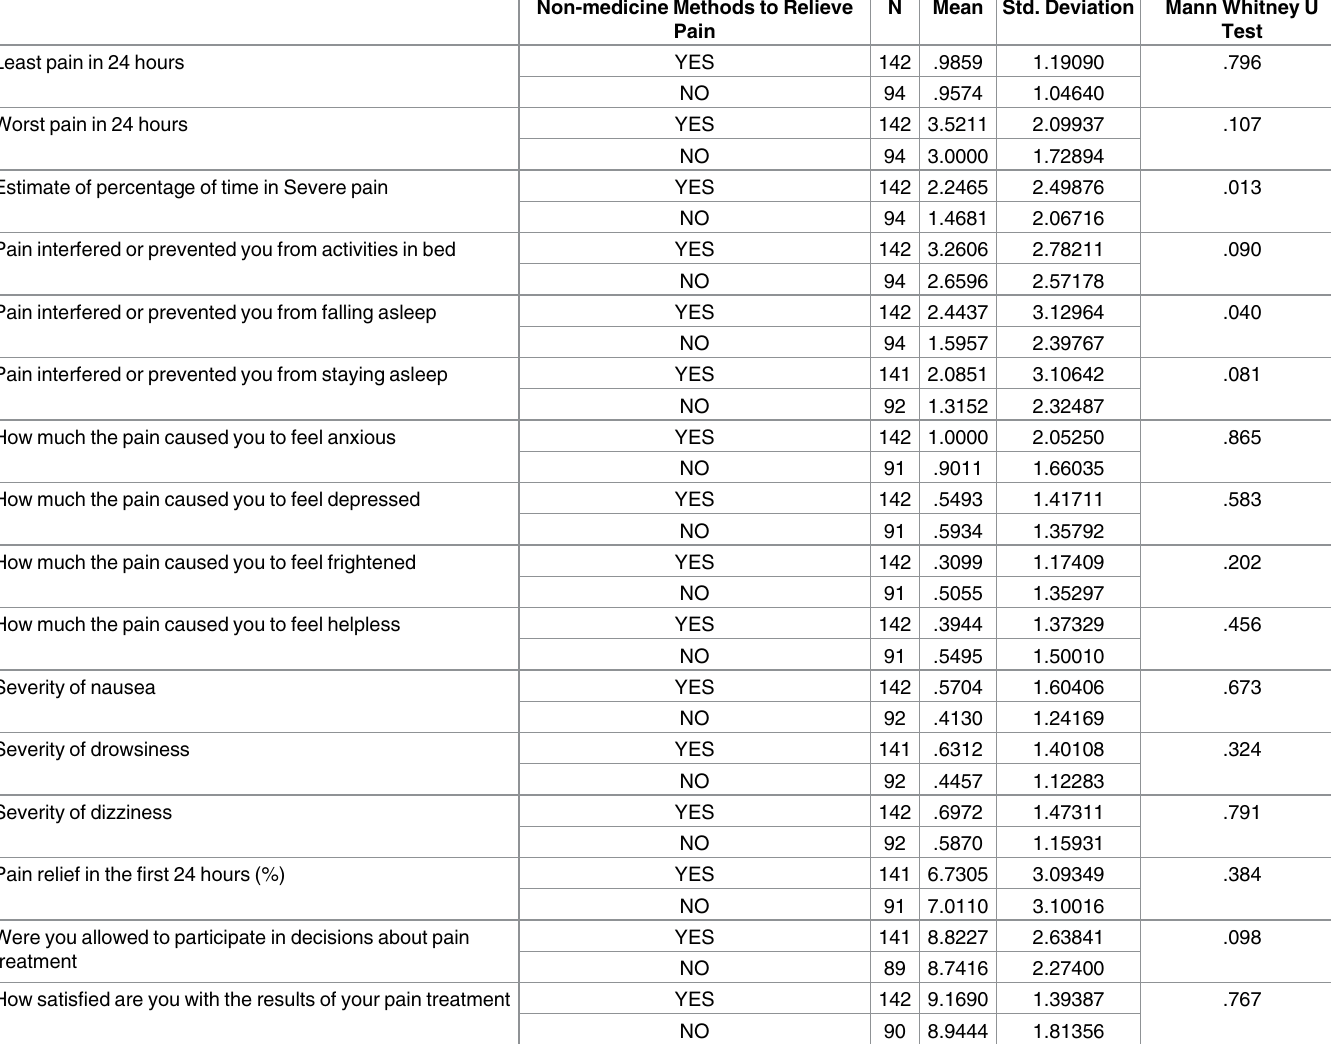
Table 5. Differencesof APS-POQ-R-C between patients with nonpharmacological therapy and nonusers.